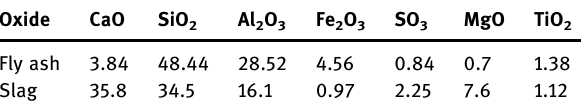
Table 3: Chemical composition of fl y ash and slag ( % )